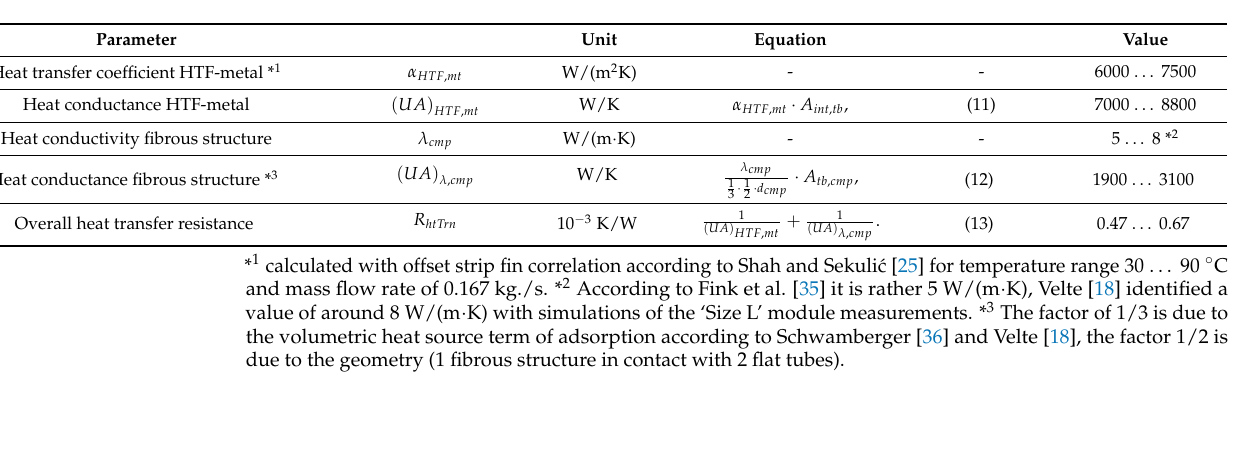
Table 4. Calculation of the overall heat transfer resistance of the adsorption heat